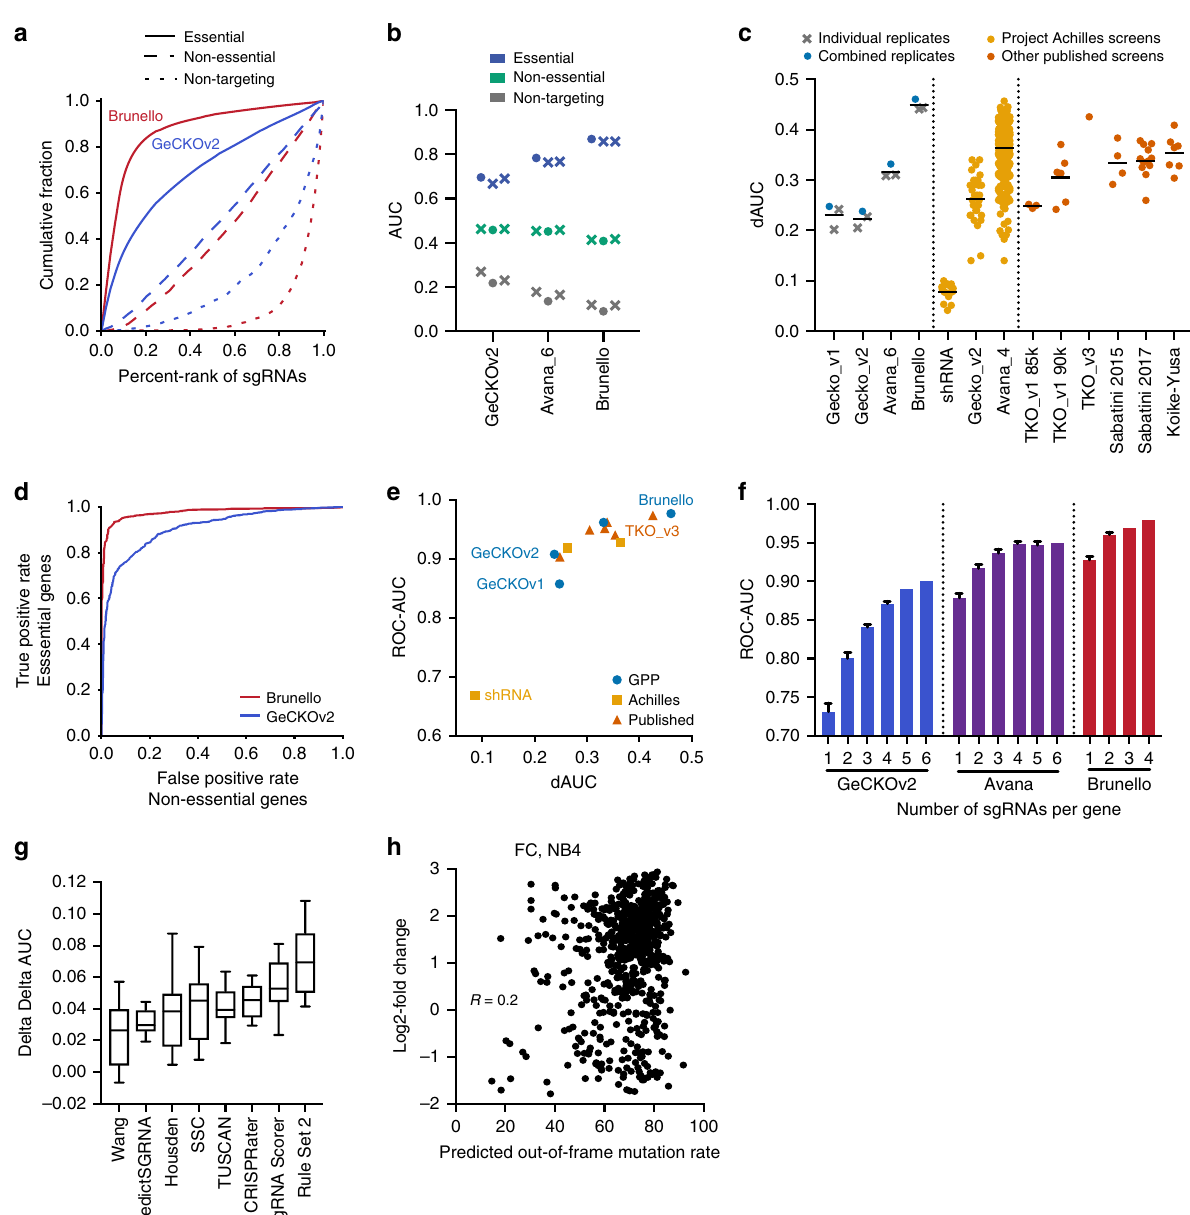
Fig. 1 Improved performance of genome-wide CRISPRko libraries. a Area under the curve analysis of cell viability screens for core essential (solid line), non-essential (dashed line), and non-targeting (dotted line) gene sets in the Brunello and GeCKOv2 library screened in A375 cells. b Comparison of AUCs for essential, non-essential, and non-targeting sgRNAs across the generations of libraries screened by this group. The AUC of individual replicates are plotted as X ’ s, while the AUC values calculated from the averaged log2-fold change of the replicates are plotted as circular points. The Avana library was screened with 6 sgRNAs per gene. c Comparison of the dAUC across different CRISPRko libraries. All published libraries are plotted as circular points from the combination of replicates, if provided. Black line represents the average of the dAUCs. For Project Achilles, a version of the Avana library with 4 sgRNAs per gene was used; the shRNA data are shown for the same 33 cell lines that were screened with GeCKOv2. d Receiver operating characteristic analysis of cell viability screening data for the Brunello and GeCKOv2 libraries screened in A375 cells. False positive rates are determined by non-essential genes and plotted against the true positive rate, determined by essential genes. e Comparison of the dAUC and ROC-AUC values for different libraries; when multiple cell lines of data were available, the mean is plotted. GPP refers to screens described here and previously by this group. f Subsampling analysis calculating the ROC-AUC of n sgRNAs per gene in three different libraries. Error bars represent s.d. calculated from different iterations of library sampling. g Difference in the dAUC (ddAUC) for various scoring schemes when applied to the 33 cell lines screened with GeCKOv2. The box represents the 25th, 50th, and 75th percentiles; whiskers show 10th and 90th percentiles. h Comparison of the predicted out-of-frame mutation rate to the previously measured log2-fold change of sgRNAs in the fl ow cytometry (FC) dataset targeting cell surface genes in the NB4 cell